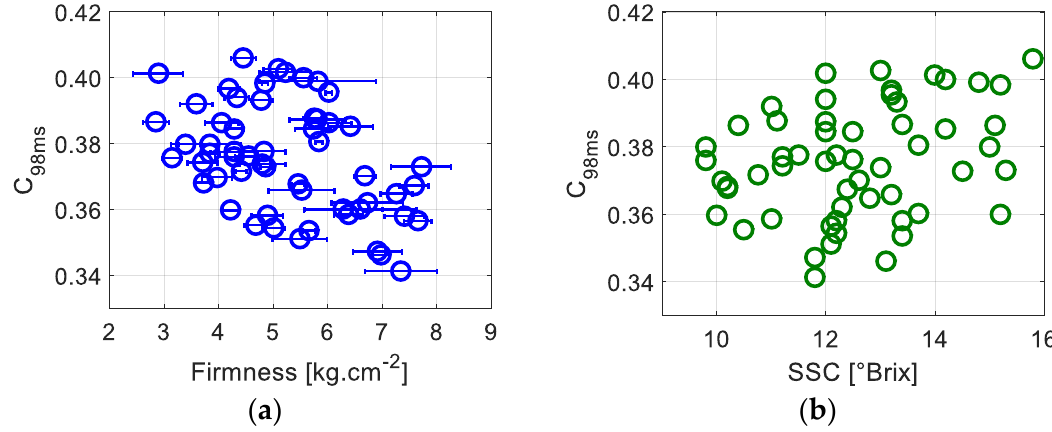
Figure 3. The contrast computed over rings with a 9.2 inner and 9.4 mm outer diameter at an exposure duration of 98 ms ( C 98ms ) as a function of the firmness ( a ) and ( b ) the SSC level. Horizontal error bars correspond to standard deviations of three different performed firmness measurements.